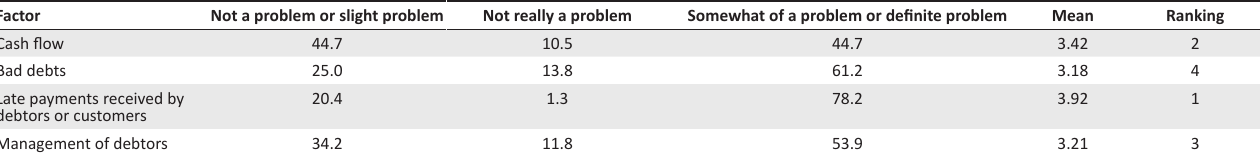
TABLE 7: Perception of trade credit mismanagement as the cause for small and medium-sized enterprise failure. How would you rate the possibility of SMEs failing, because of mismanagement of trade credit by managers within the SME?